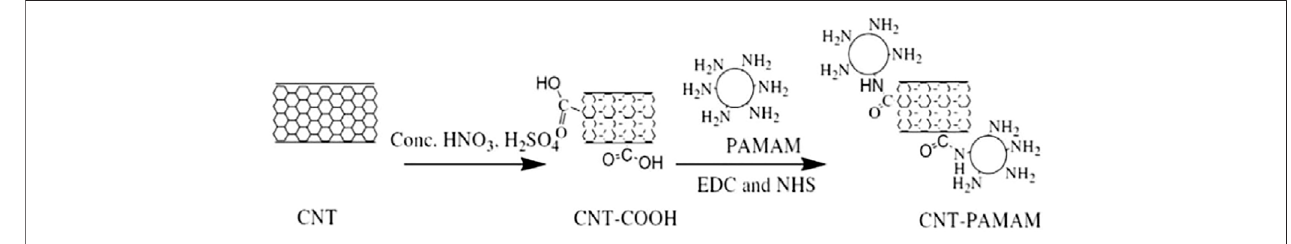
FIGURE 3 | Synthesis process of PAMAM/CNT nanocomposites.